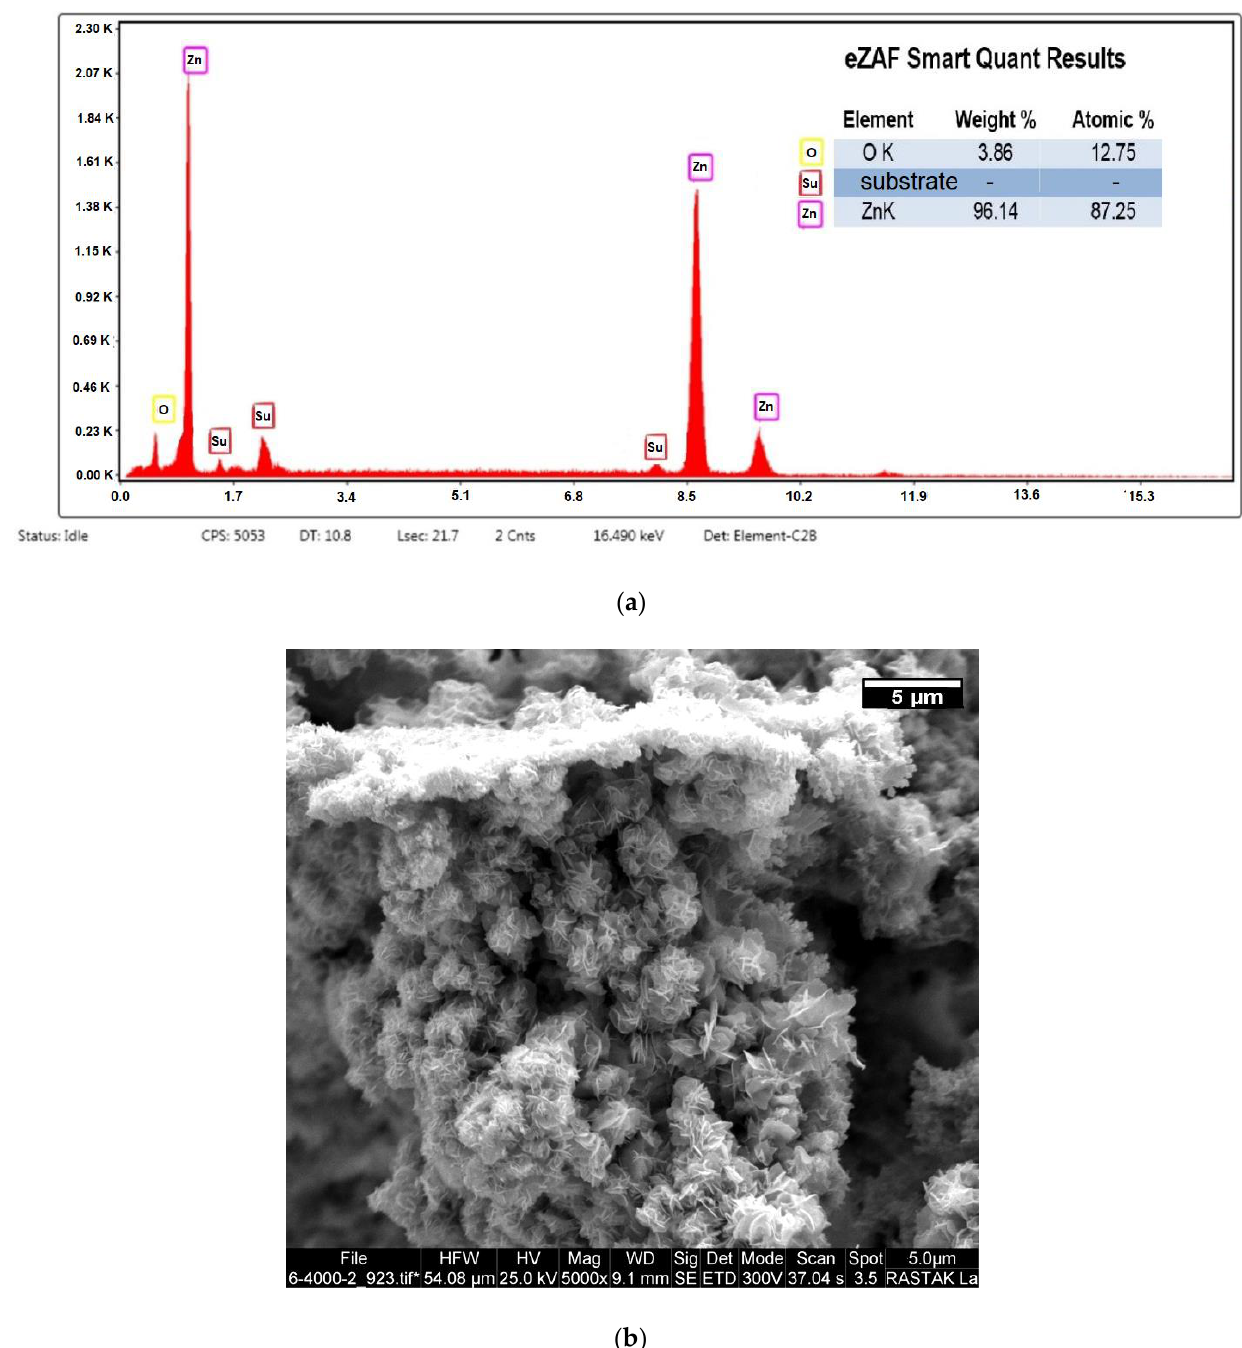
Figure 5. ( a ) EDS test results with an electron microscope for a sample of 10 h electroplated (sample 7), which shows the formed zinc and oxygen. ( b ) SEM photo from area which EDS was taken.